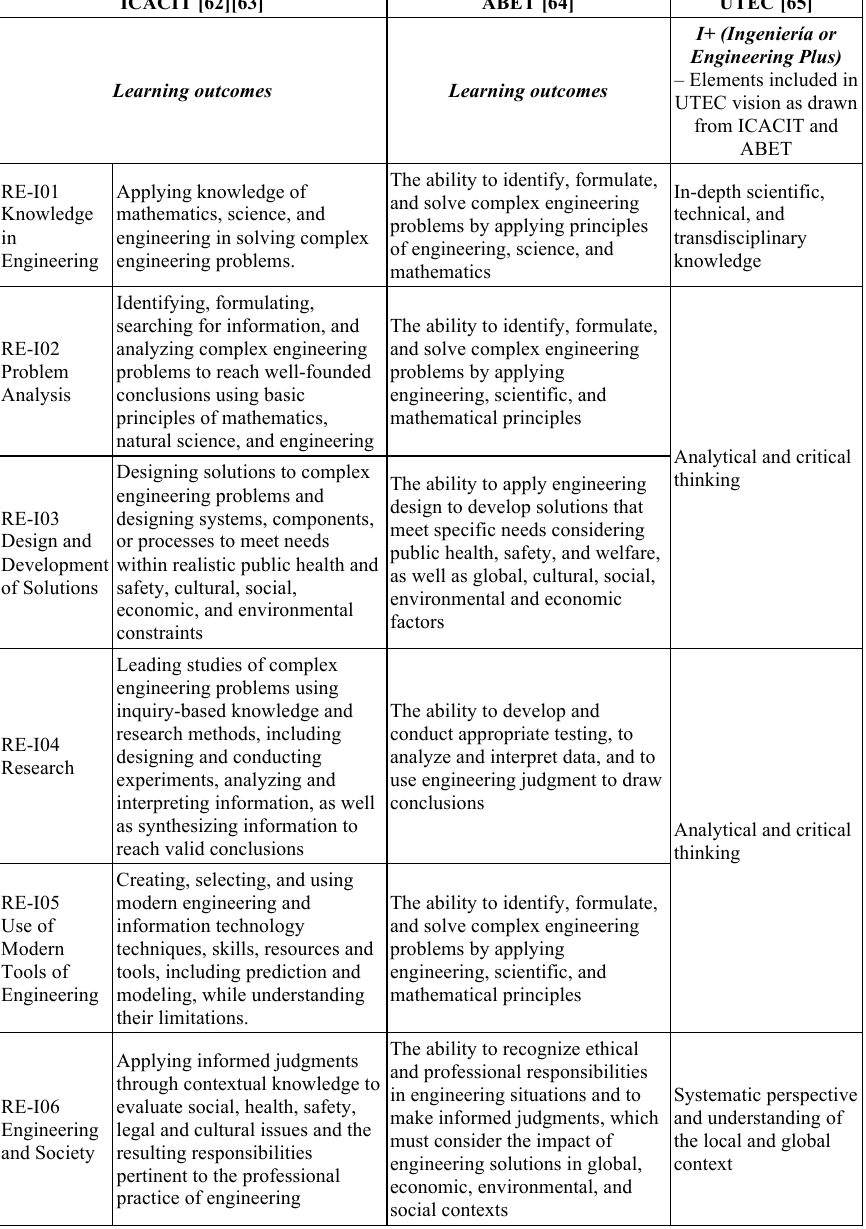
Table 1. A comparison of learning outcomes of ICACIT and ABET, and elements of UTEC